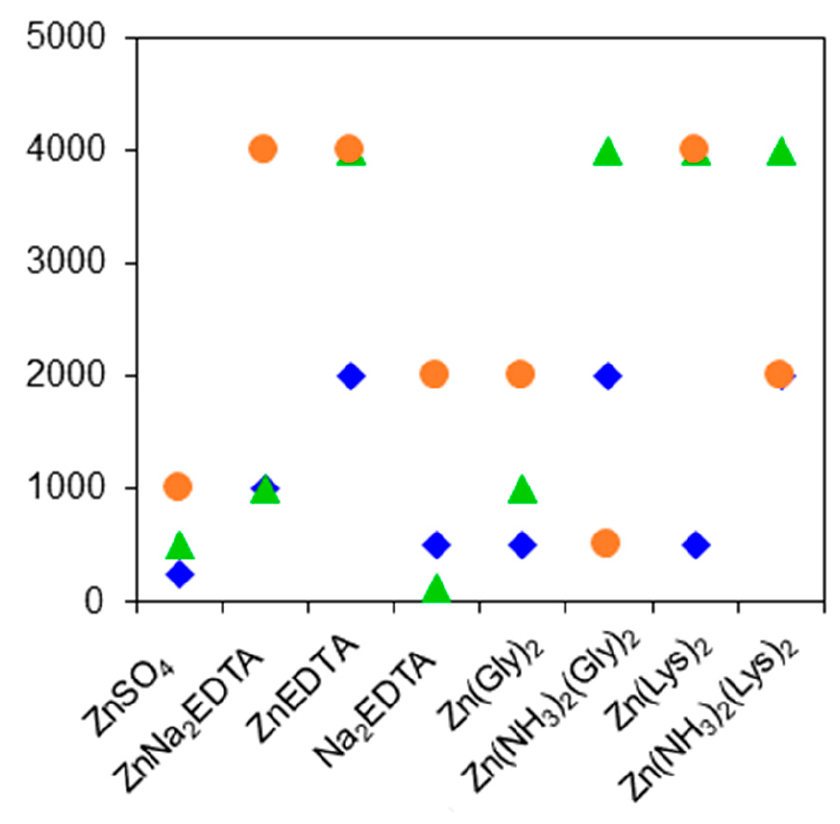
Figure 2. Minimal inhibition concentrations (MICs) of the eight investigated compounds on the three beneficial microorganism strains. MIC values are shown by green triangles for L. lactis ( ▲ ), blue rhombi for B. subtilis ( ♦ ), and orange dots for S. cerevisiae ( ● ).